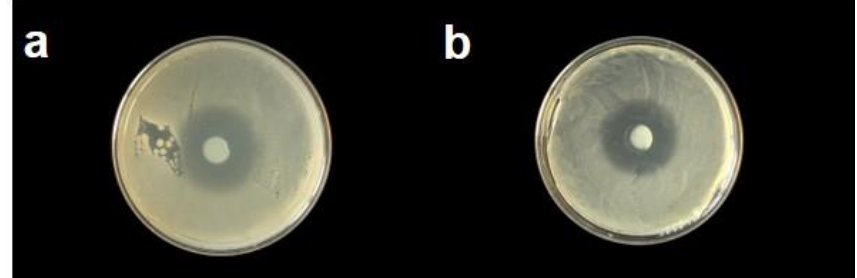
Figure 7. Evaluation of antibacterial action by an Agar diffusion test: ( a ) calcined (450 °C) ZnO-BAC nanostructures; ( b ) dried (120 °C) ZnO-PDDA nanostructures.